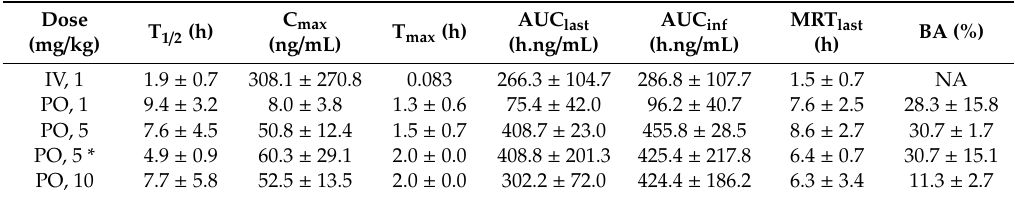
Table 4. Plasma pharmacokinetic parameters of ABN401 in beagle dogs following intravenous (IV) and oral (PO) administration of 1, 5, and 10 mg / kg body weight (mean ±